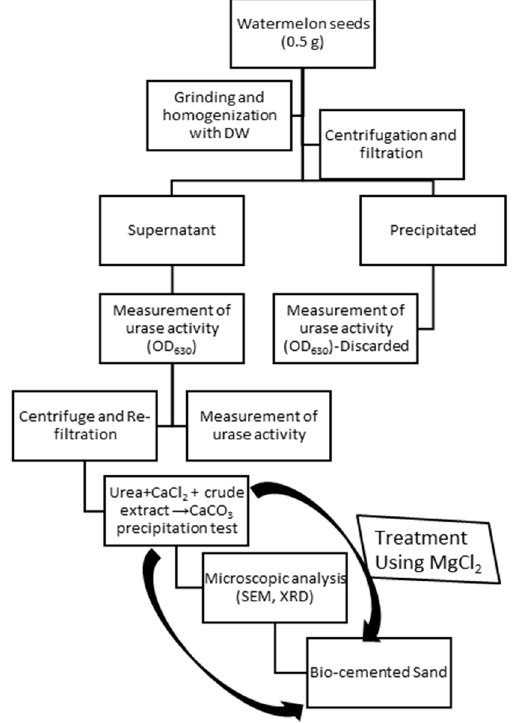
Figure 2. Experimental procedure used in this study (DW—distilled water; SEM—Scanning Electron Microscope; XRD—X-ray Diffraction).